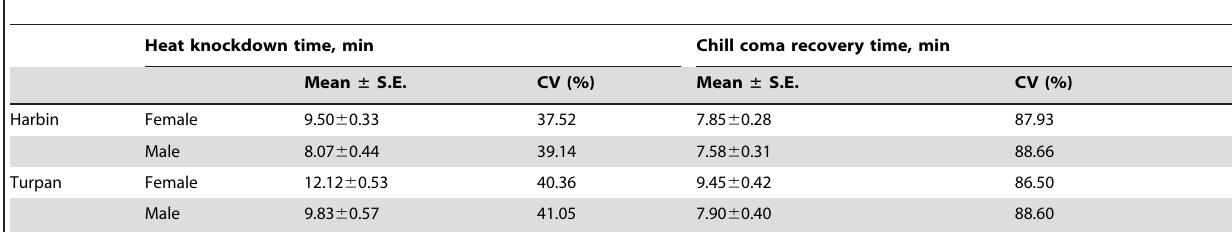
Table 1. Mean, standard error (1 S.E.), and coefficients of variation for the thermal resistance of the Harbin and Turpan populations of B. tabaci MED cryptic